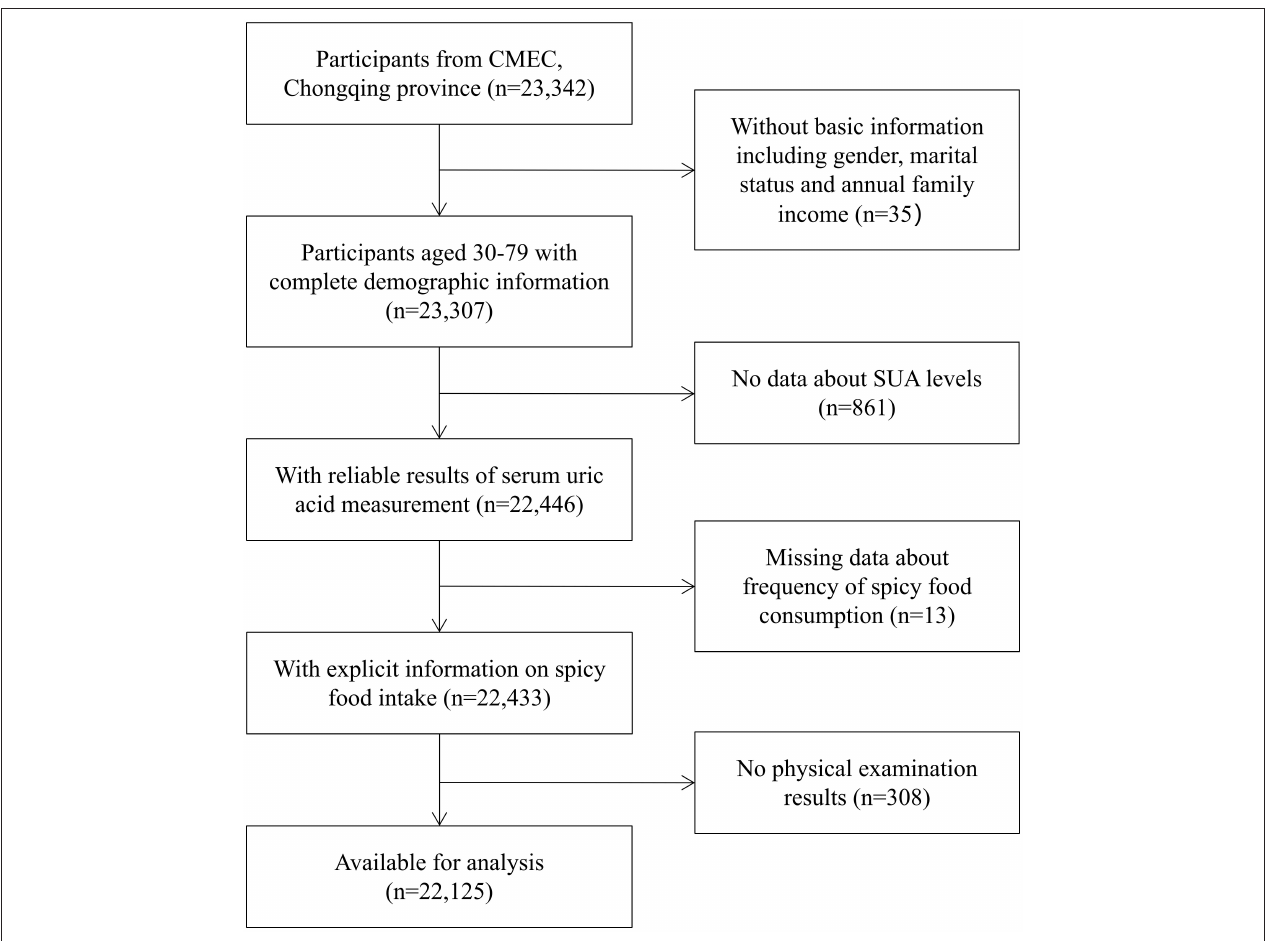
FIGURE 1 | Flowchart for participants’